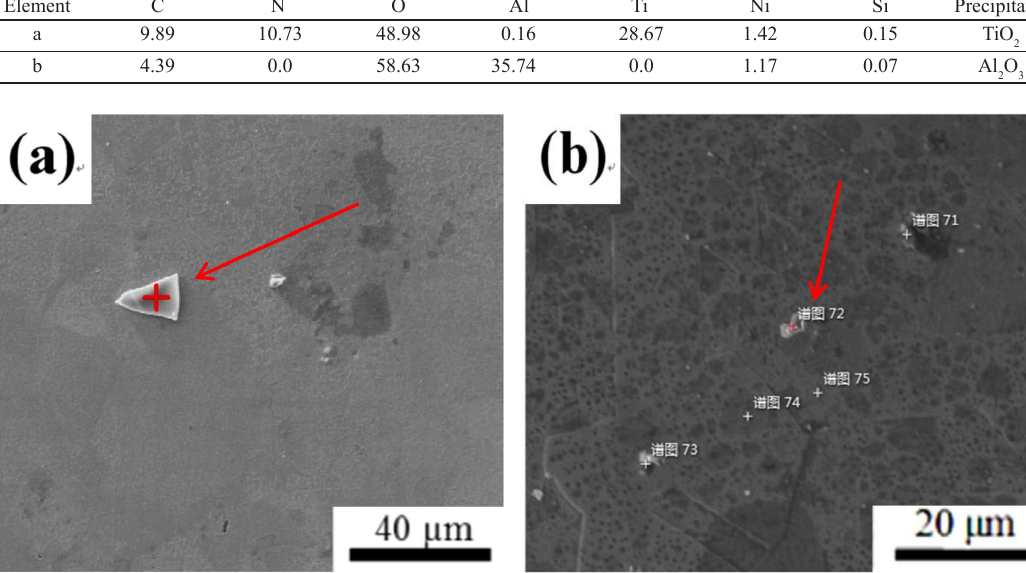
Figure 14. The precipitated phases in the wire-filled PAW joint (a) TiO